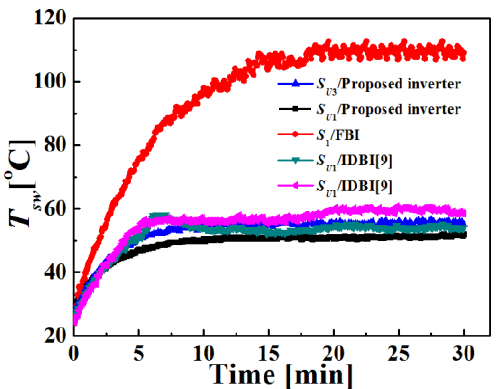
Figure 13. Switch temperature T SW vs. time of operation, measured at V in = 400 V DC , V grid = 220 V AC /60 Hz, f s = 20 kHz, P o = 2 kW, and Q o = 0 VAR.